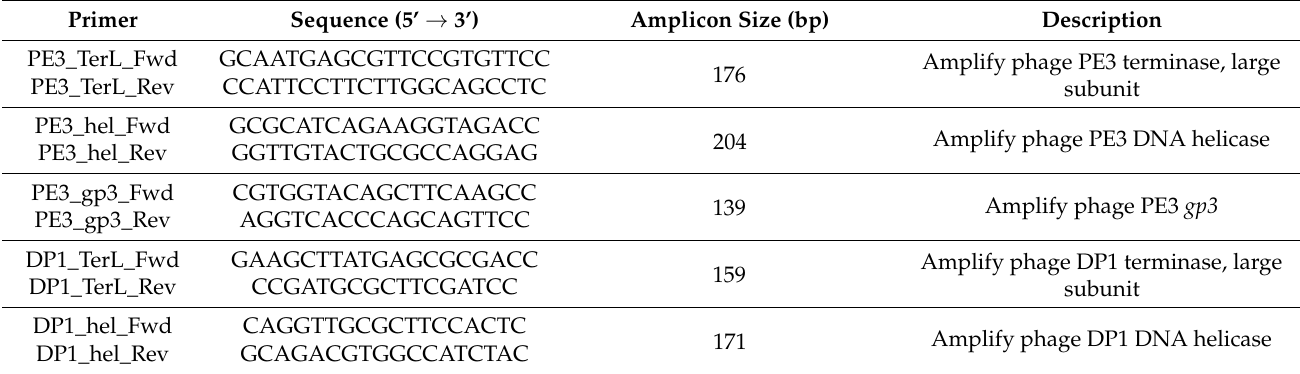
Table 1. Primers used in this